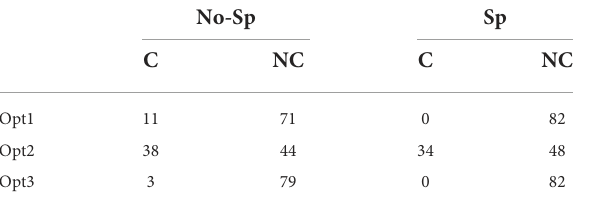
TABLE 2 Participation results with optimal patterns without/with social pressures.